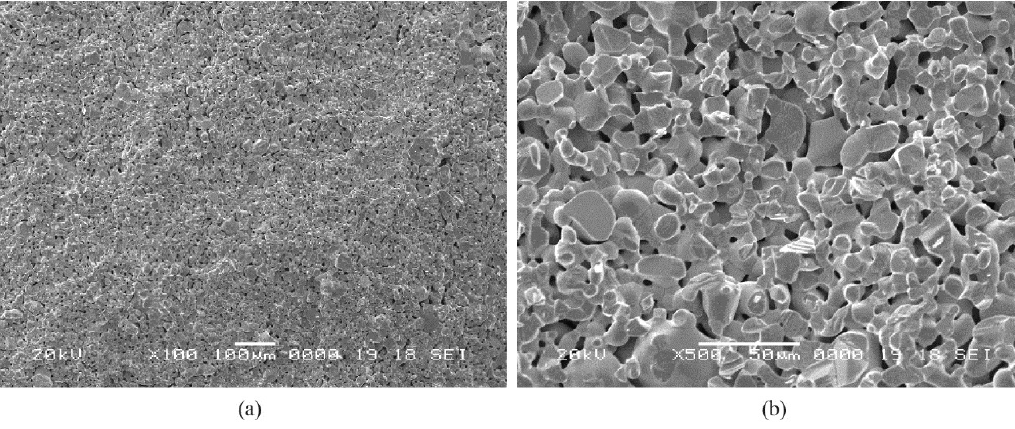
Figure 2. SEM images of the conventional ITO tablets at (a) low and (b) high